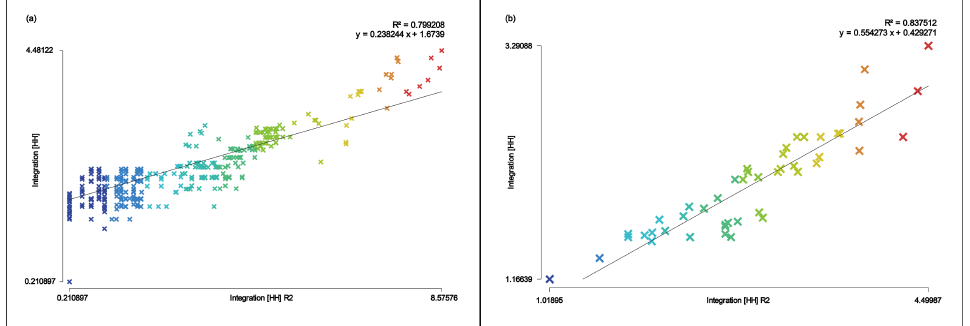
Figure 5. ( a ) Synergy of Chang’an of the Tang Dynasty and ( b ) synergy of Dongjing of the Northern Song Dynasty.